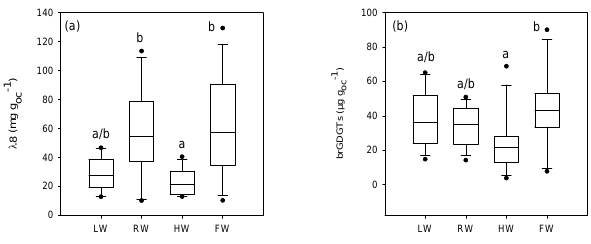
Figure 6. Box plots of seasonal average values of total lignin phe- nol and brGDGTs. Letters indicate statistically significant groups of data ( p